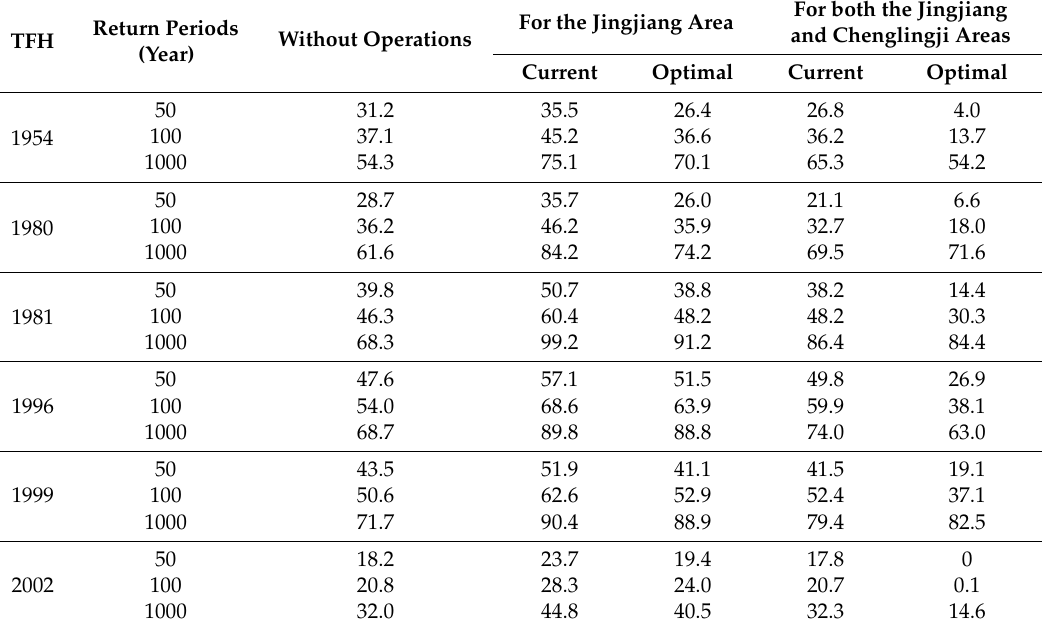
Table 9. Flood diversion volumes of some design flood hydrographs at the Chenglingji flood control point (billion m 3